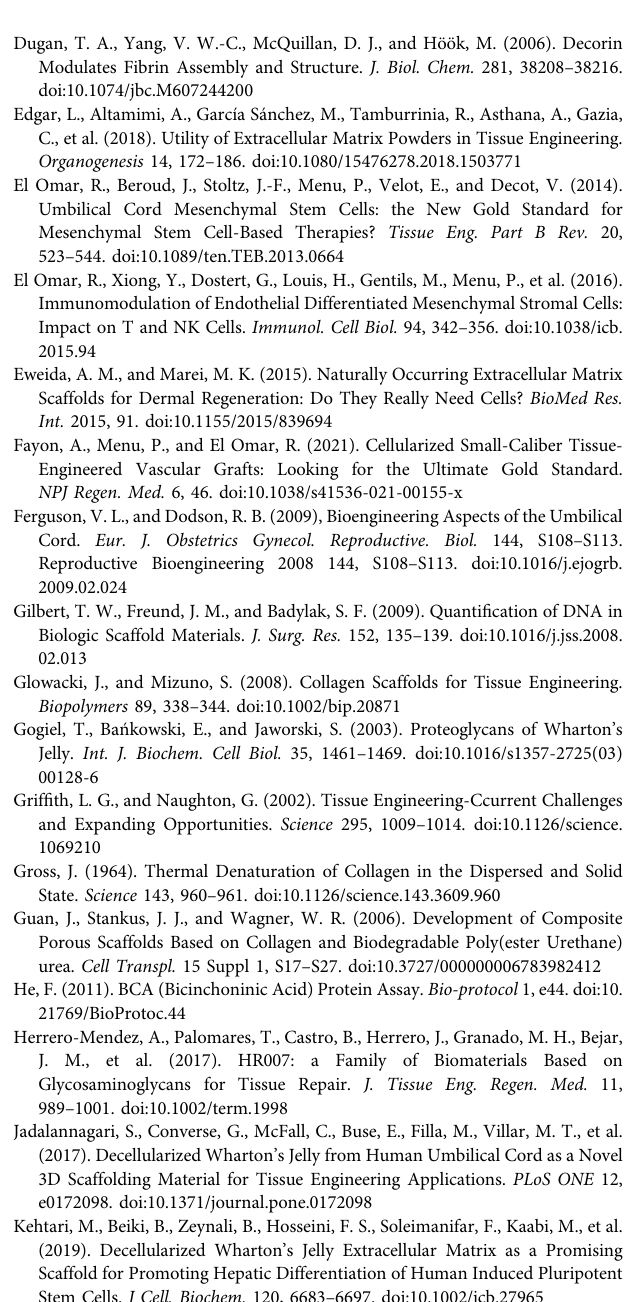
Supplementary Figure S1 | Chart pie of identi fi ed proteins composing the WJ-ECM. Supplementary Figure S2 | WJ-MSC phenotypic characterization by fl ow cytometry including 945 showing positive expression of CD90 (FITC anti-human CD90, BioLegend, 328108), CD44 946 (PE/Cy7 anti-human CD44, BioLegend, 338816), CD73 (Brilliant Violet 421TM anti-human 947 CD73, BioLegend, 344008), and CD105 (APC anti-human CD105, BioLegend, 323208) and a 948 lack expression of CD45 (PE anti-human CD45, BioLegend, 304008), CD34 (PE anti- human 949 CD34, BioLegend, 343506), HLA-DR (PE anti-human HLA-DR, BioLegend, 307606) and CD86 950 (PE anti-human CD86, BioLegend,